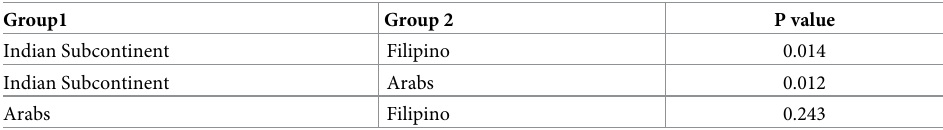
Table 3. Post hoc test for mean score of WBC by nationality among the